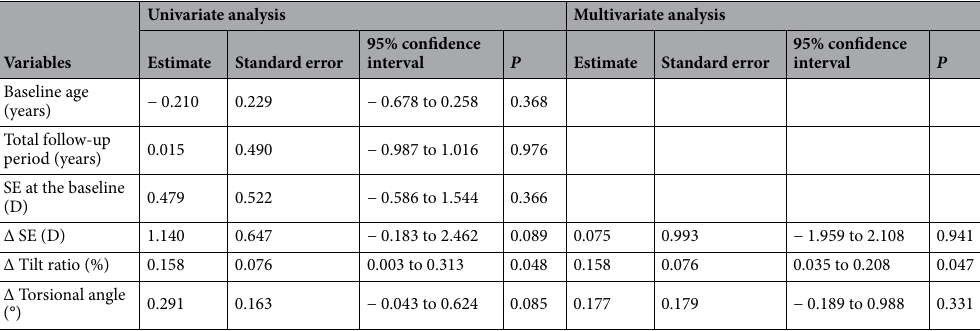
Table 2. Univariate and multivariate mixed-effects model determination of factors associated with changes of circumpapillary retinal nerve fiber layer thickness (cpRNFLT) distribution during childhood myopic progression. SE spherical equivalent, Δ change. The results show factors associated with greater change in cpRNFLT distribution without scan-circle repositioning. The ‘change of cpRNFLT distribution’ was defined as the sum of differences in distribution proportion in all four quadrants between the baseline and the final visit (in absolute